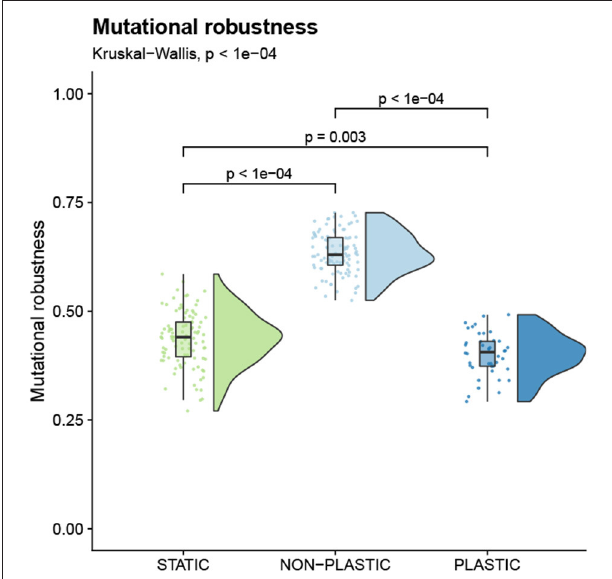
FIGURE 5 | Mutational robustness. Raincloud plot of mutational robustness of each representative genotype ( Table 1 ). The plot is annotated with statistically significant comparisons (Bonferroni-corrected pairwise Wilcoxon rank-sum